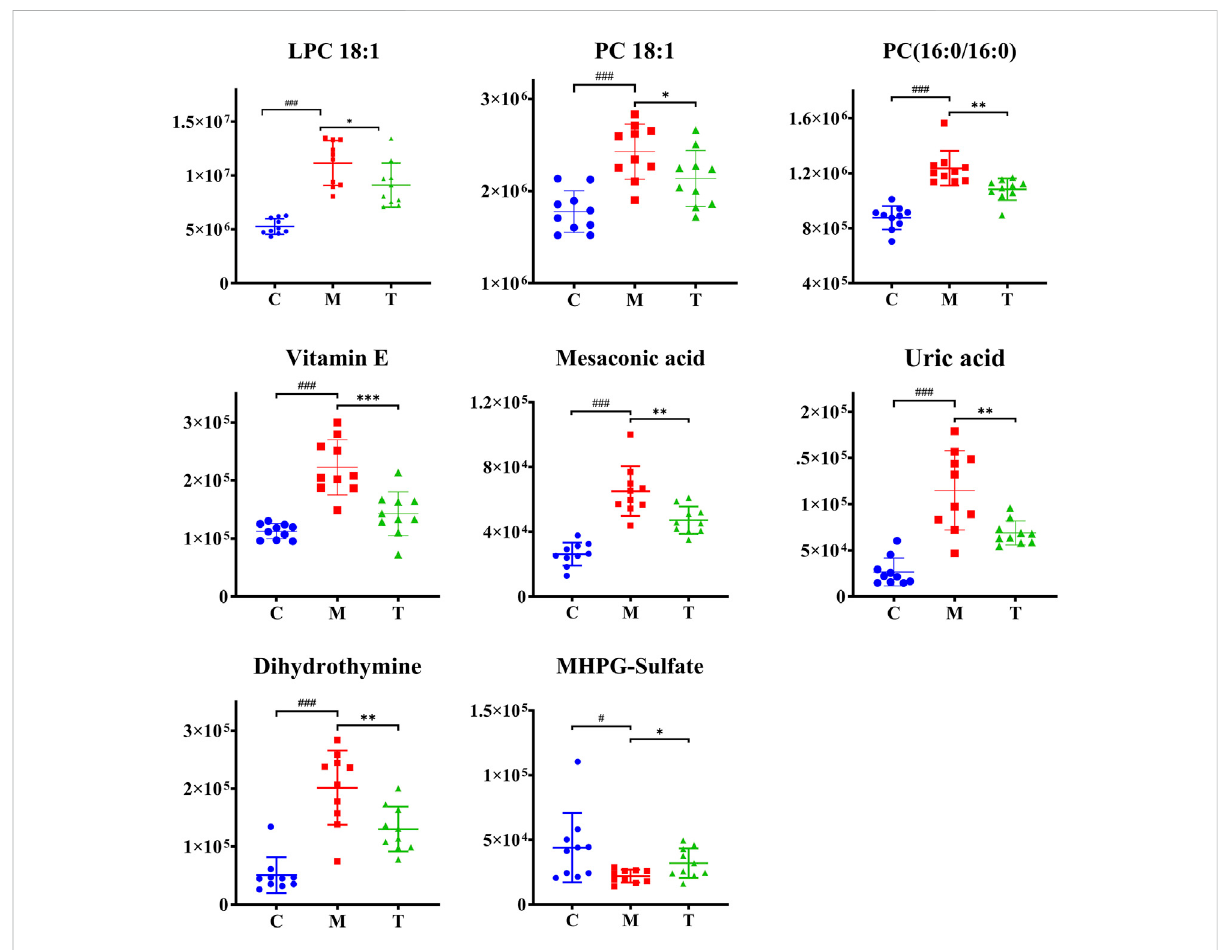
FIGURE 8 Scatter graph of metabolites changes in coal tar-induced acne in rabbits treated by isotretinoin. Group C vs. group M, # p < 0.05, ## p < 0.01, ### p < 0.001; group M vs. group T, * p < 0.05, ** p < 0.01, *** p <